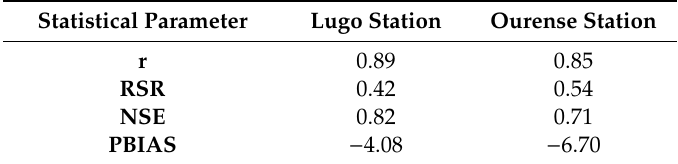
Figure 4. Forecasted (grey circles) and measured (black asterisks) river flow at ( a ) Lugo and ( b ) Ourense locations for the whole period 2012–2019. Table 4. Statistical analysis of the performance of forecasted river flow respect to measured data considering only extreme river flow events above the 99th percentile over the period 2012–2019.